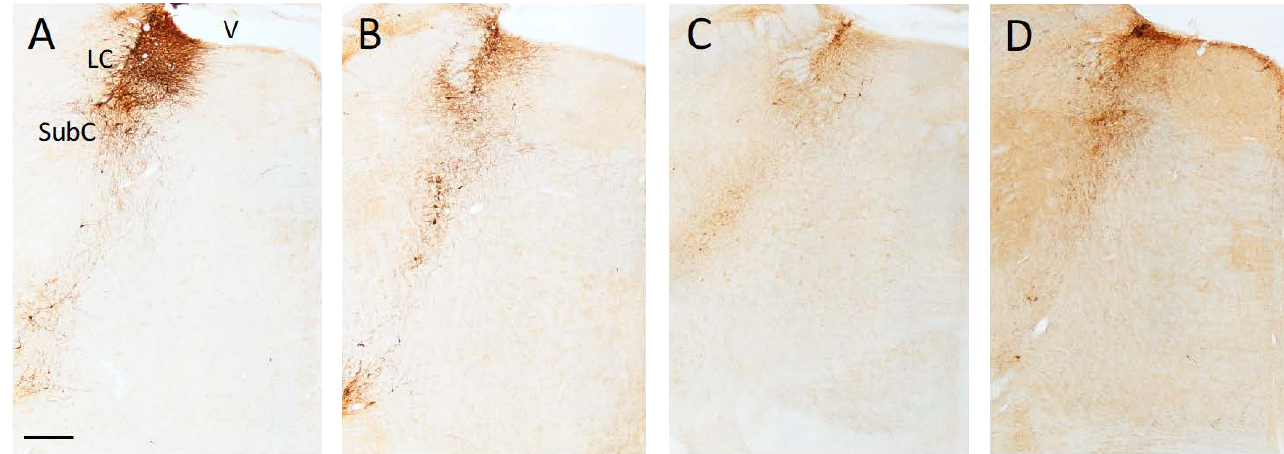
Figure 4. Representative photomicrographs of DBH-immunostained coronal sections illustrating the distribution of noradrenergic neurons in the LC and SubC nuclei of Control ( A ), Lesioned ( B ), LC-transplanted ( C ) and CBL-transplanted animals ( D ). Note in B-D, the lesion-induced loss of immunoreactive neurons and proximal processes was fairly complete in the dorsalmost part of the nucleus, with some sparing in the more ventral SubC region. Scale bar in A: 500 µm. LC, Locus Coeruleus; SubC, SubCoeruleus complex; V, Ventricle.